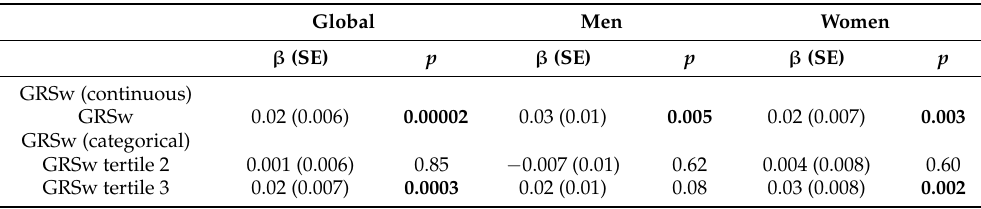
Table 3. Association between GRSw and fasting blood glucose levels (log) as continuous and categorical variable.